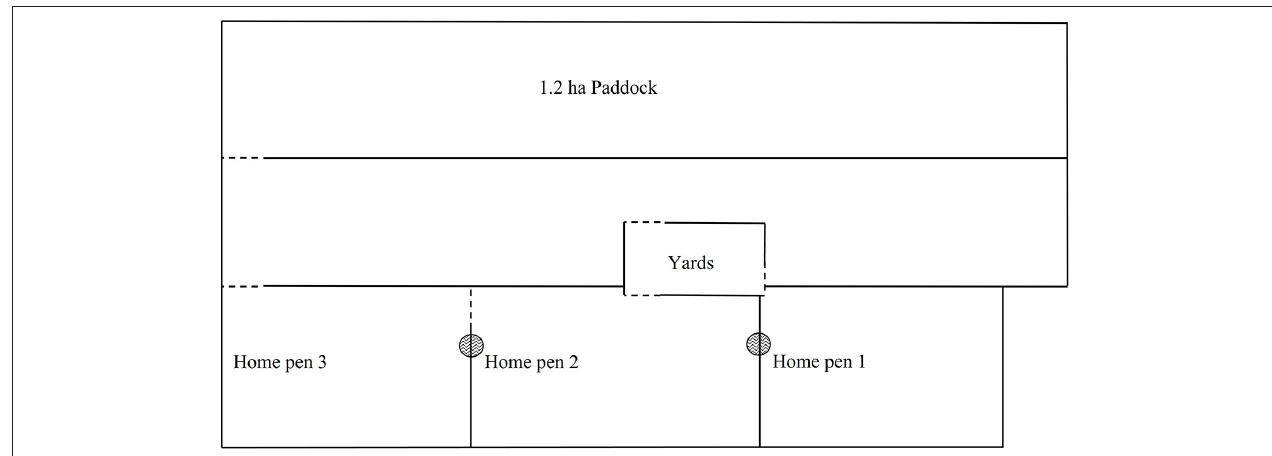
FIGURE 1 | Experimental site (not to scale). The home pens were used to house cows during the neckband acclimatization and pasture regrowth periods. Water and shade were accessible in all home pens with a feed bunk in each used to feed out hay daily at maintenance level. The cattle yards were accessible from the home pens and contained multiple smaller pens and a cattle crush. The annual ryegrass paddock was used for both the training period and strip grazing. water;